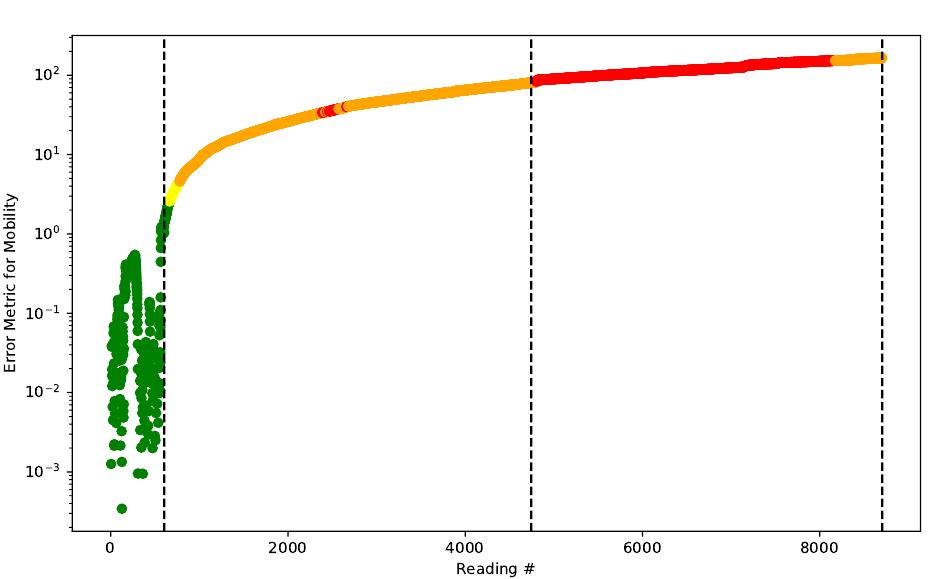
Figure 11. Evolution of the error metric for mobility and the correspondent status of the